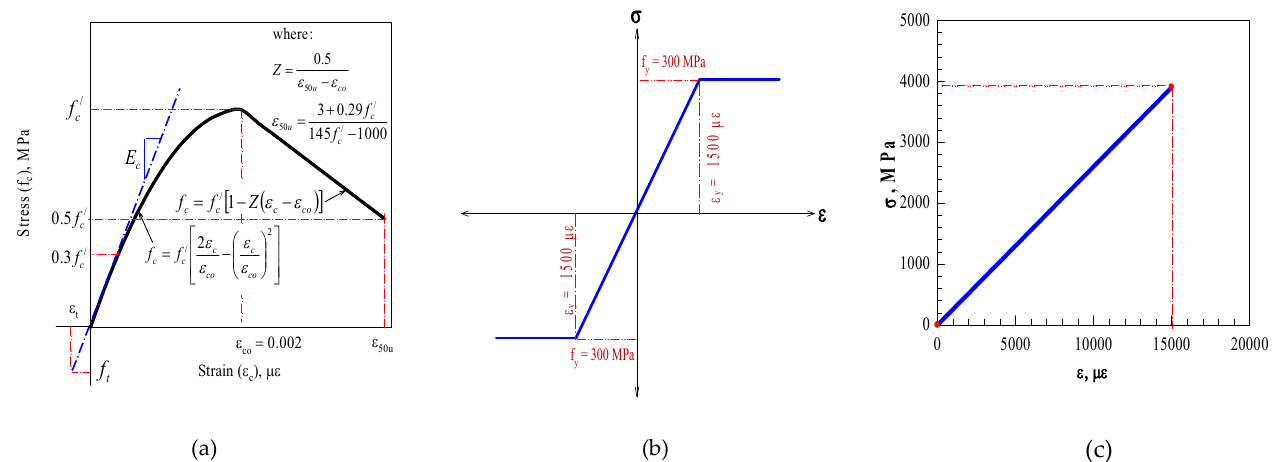
Figure 2. Material mechanical characteristics. ( a ) Concrete compressive strength [56], ( b ) Concrete tensile strength [33], ( c ) CFRP [57].